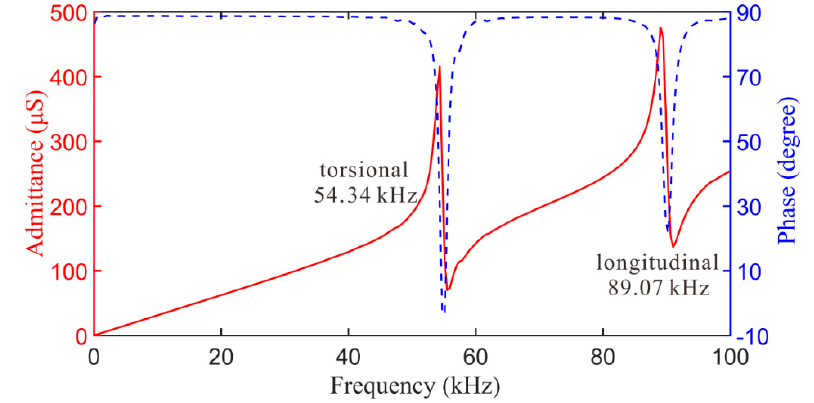
Figure 5. Dynamic response of the PA.